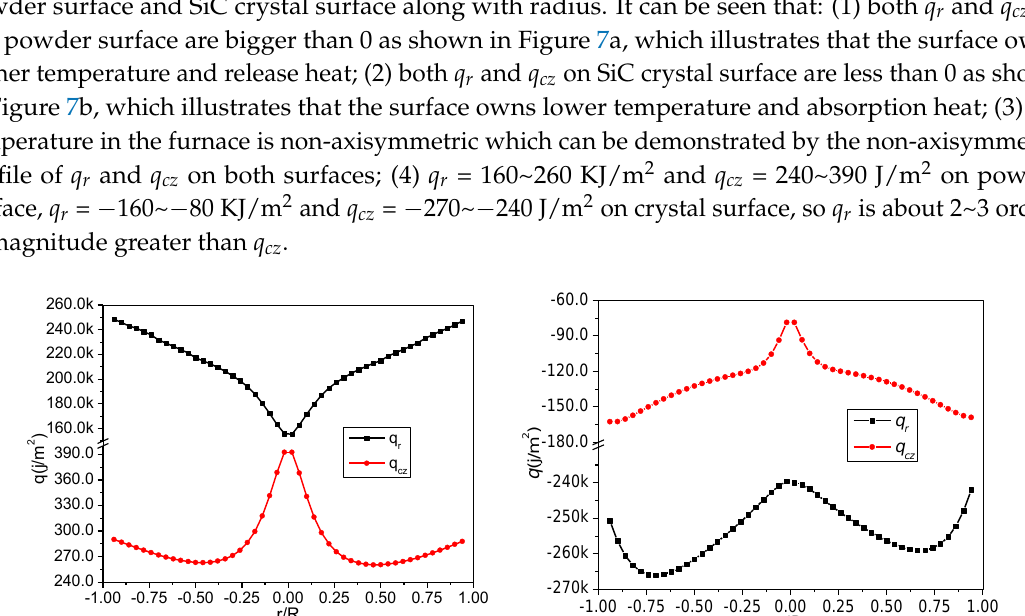
Figure 6. Profiles of A 0 r and A 0 i in r-direction for axisymmetric and spiral coil at I = 1250 A and F = 16 kHz. ( a ) A 0 r ; ( b ) A 0 i .